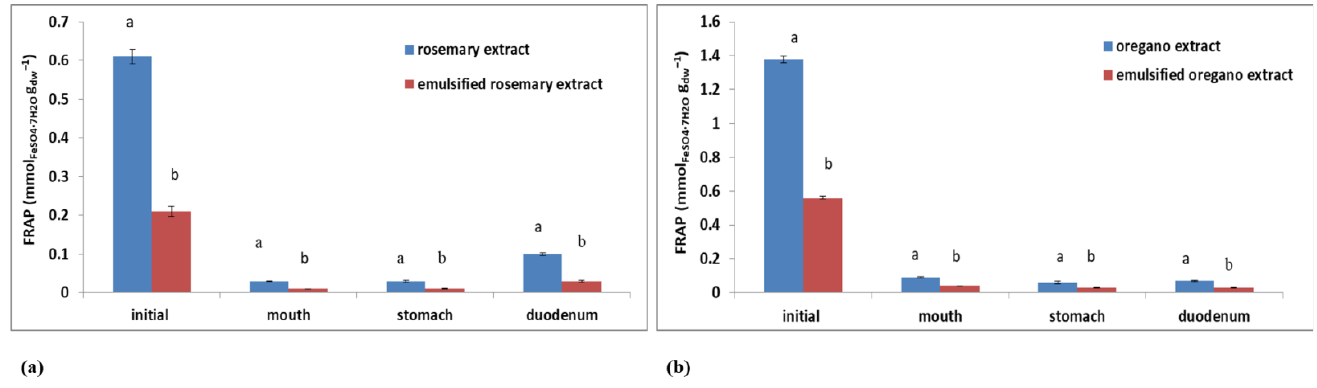
Figure 9. Changes in the antioxidant activity (FRAP) of plant extracts and oil-in-water emulsions containing extract during in vitro digestion for ( a ) rosemary and ( b ) oregano. Different letters above the columns represent significant differences at p < 0.05.